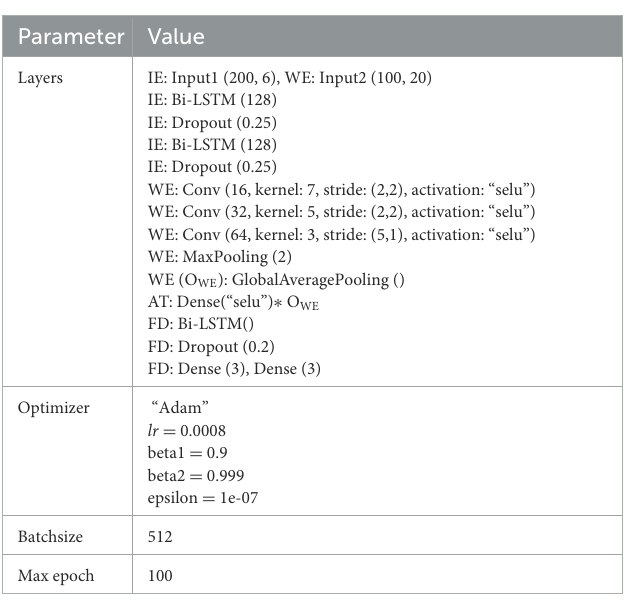
TABLE 2 Parameter settings of SmartFPS.